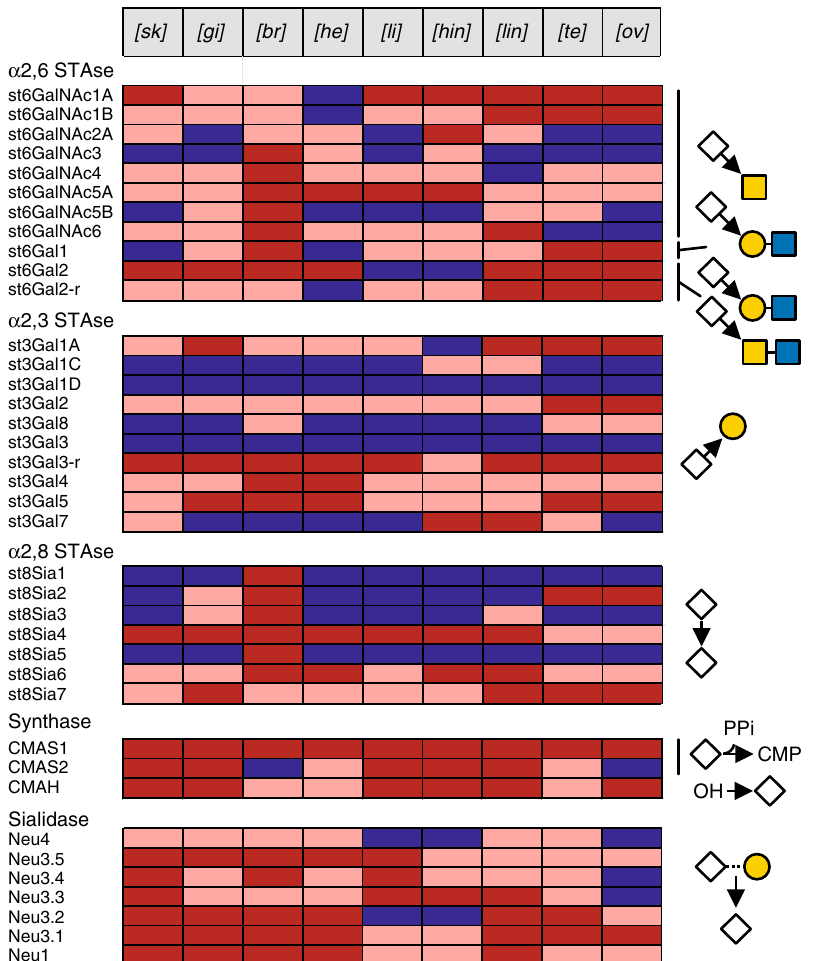
Fig. 7 Sialo-genes expression. Expression pro fi les of sialyltransferases, CMP-sialic acid synthases (CMAS), sialidases (Neu), CMP-sialic acid hydroxylases (CMAH), and sialidases genes in various zebra fi sh tissues based on RT-PCR data (Supplementary Figure 7). Expression levels of single mRNAs were depicted according to their relative intensities in each organ as non-detected (blue), intermediate intensity (pink), and strong intensity (red). Putative activities based on phylogenetic analyses are depicted at the right side of the